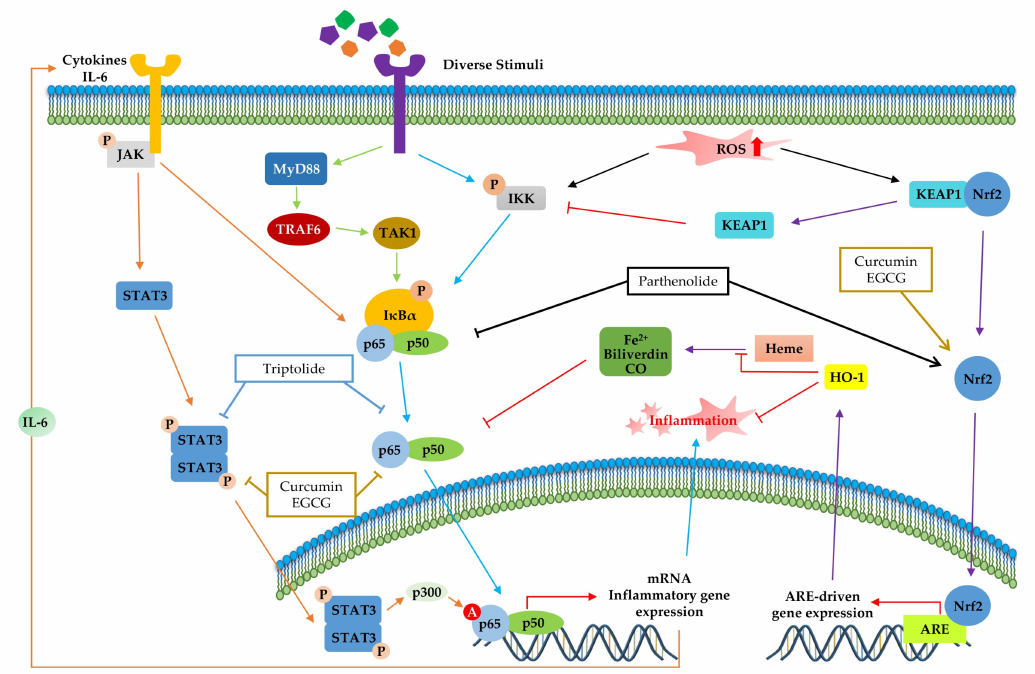
Figure 5. Crosstalk among inflammation-related transcription factors. The products of inflammatory mediators, such as cytokines and reactive oxygen species (ROS), are produced continuously by various inflammatory responses. Activated JAK and TAK1 modulate the phosphorylation of I κ B α . Furthermore, the activated SATA3 dimer can translocate to the nucleus and activates the NF- κ B transcription factor via p300-mediated acetylation. Accumulated ROS disrupts the Keap1-Nrf2 complex and